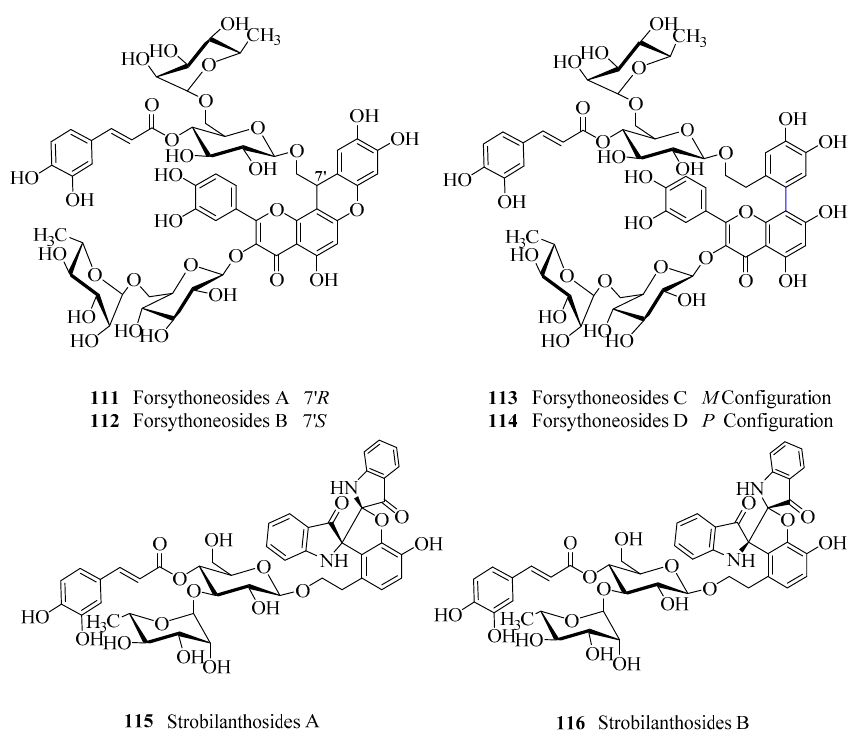
Figure 1. The new phenylethanoid glycosides with varied core structures or special substituents.